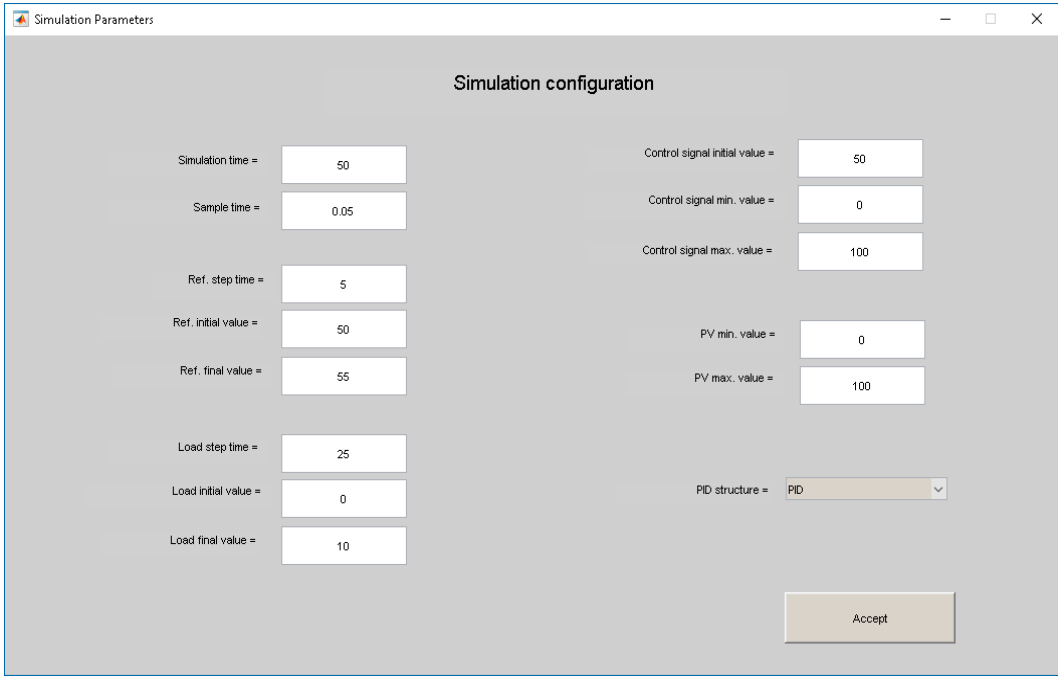
Figure 8. Simulation configuration window.